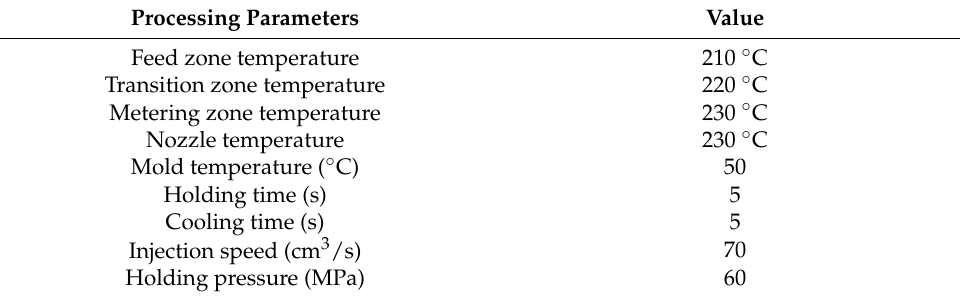
Table 2. Parameters of the injection process of PP samples with